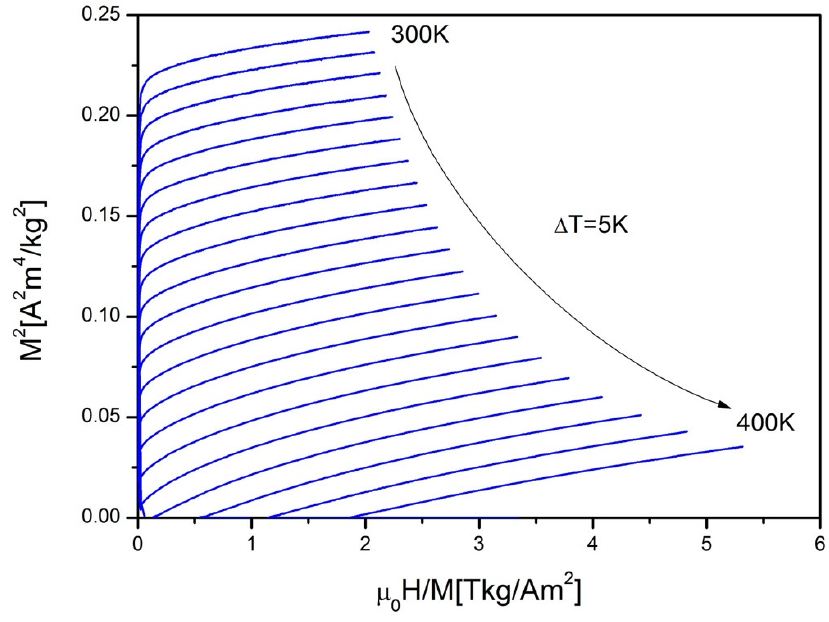
Figure 6. The Arrott plots constructed for studied material.